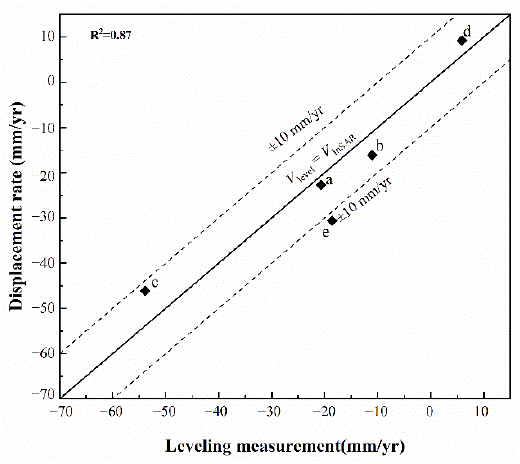
Figure 5. Comparison of subsidence from the leveling benchmarks data and InSAR results.